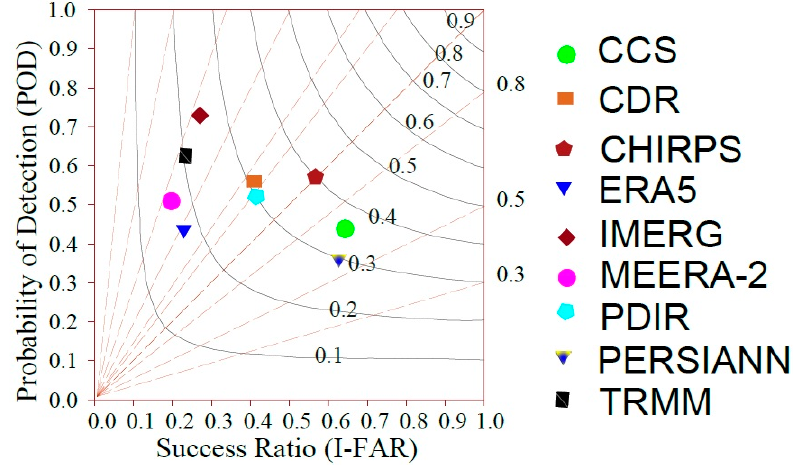
Figure 16. The probability of the detection of the reanalysis and SPPs to correctly represent the occurrence of daily precipitation over the entire country. Remote Sens. 2022 , 14 , x FOR PEER REVIEW The skills of the considered precipitation data products to correctly identify the